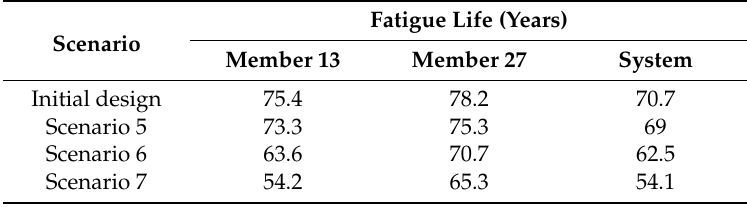
Figure 10. Comparison of updated reliability indices for equality cases (Scenarios 5–7 in Table 3). ( a ) Member 13; ( b ) Member 27; ( c ) System. Table 5. Fatigue lives for equality cases (Scenarios 5–7 in Table